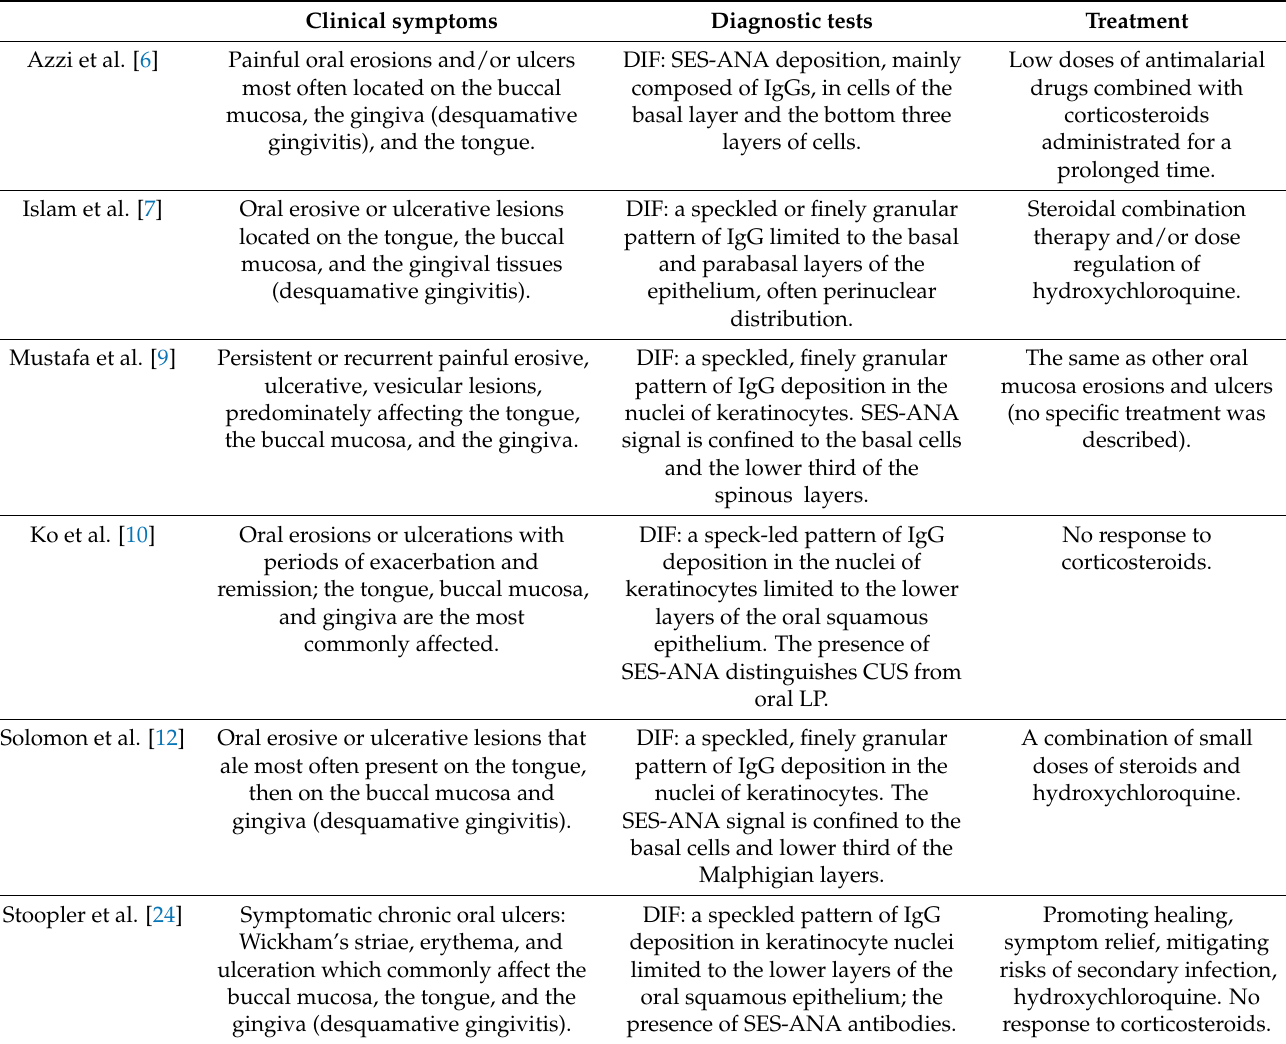
Table 3. Clinical symptoms, diagnostic tests, and treatment methods of